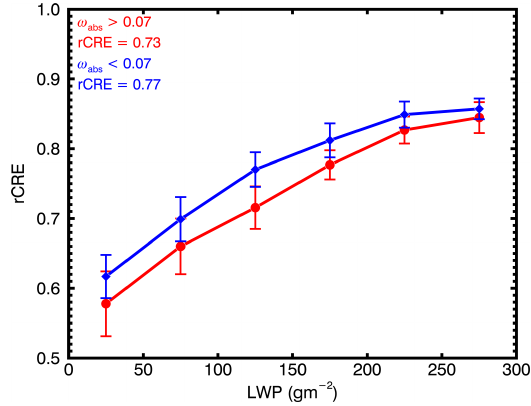
Figure 9. Relative cloud radiative effect (rCRE) as a function of liquid water path (LWP) under the strongly absorptive (in red) and weakly absorptive (in blue) aerosol regimes. Whiskers denote 1 standard deviation for each